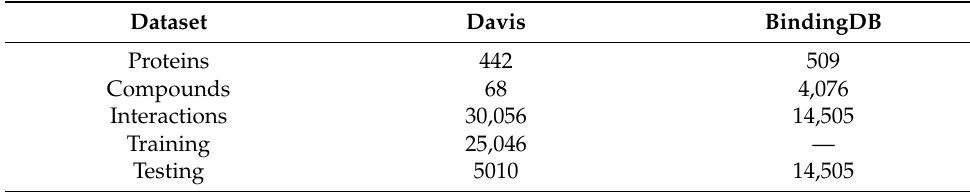
Table 1. Datasets used for model training, validation, and testing.